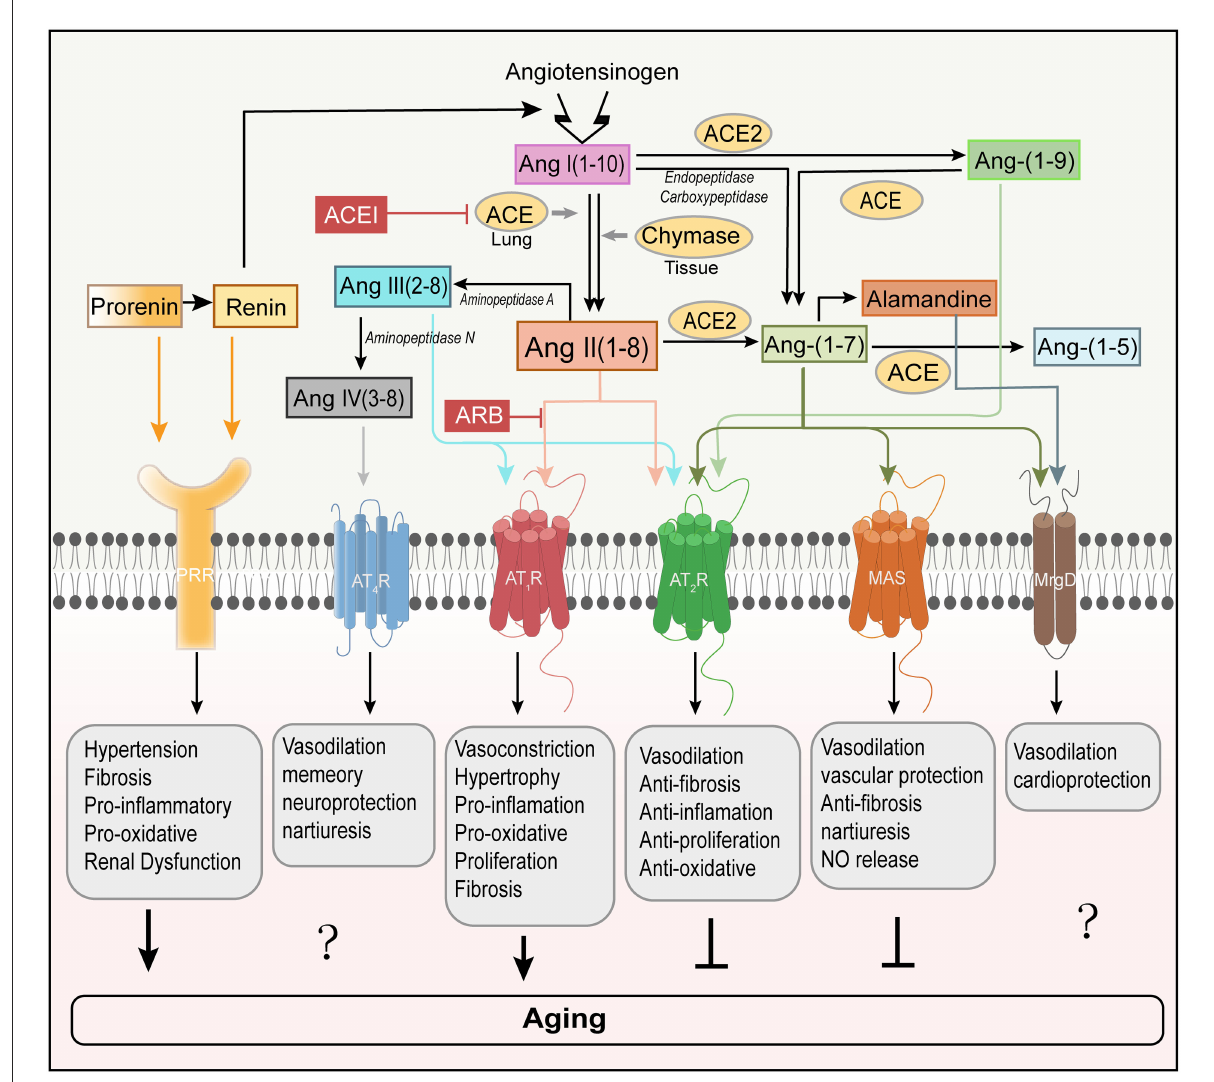
FIGURE1 Involvement of RAS peptides and receptors in aging regulation. The classical RAS positively regulates the induction of aging by activating AT 1 R. In contrast, AT 2 R is regarded as a counterbalance to AT 1 R-mediated aging. PRR is a new member of the RAS receptors and mediates aging (Yoshida et al., 2019). Ang-(1–7) binds to MAS to counter-regulate of AT 1 R-mediated aging. However, the roles that Ang-(1–7) receptor MrgD and Ang IV receptor AT 4 R play in aging remain unclear. ACE, angiotensin-converting enzyme; ACE2, angiotensin converting enzyme 2; ACEI, angiotensin-converting enzyme inhibitor; ARB, angiotensin receptor blocker; AT 1 R, angiotensin type I receptor; AT 2 R, angiotensin type 2 receptor; AT 4 R, angiotensin type 4 receptor; MrgD, Mas-related-G protein-coupled receptor; PRR, (pro)renin receptor; NO, nitric